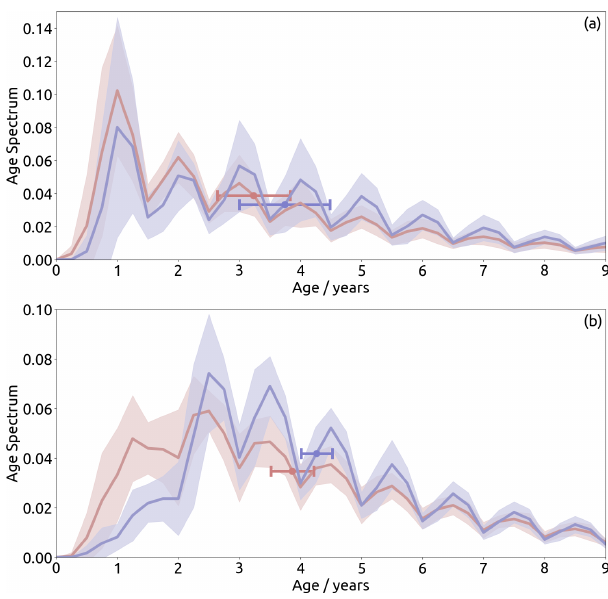
Figure 9. Age spectra from EMAC-FFSL (red) and EMAC-CLaMS (blue) within (a) the northern polar vortex (480K, 70–90 ◦ N, Jan- uary) and (b) the southern polar vortex (90–70 ◦ S 450K, July). Lines indicate multi-annual mean with shading showing annual variability. Dots indicate mean age of spectra, with surrounding bars showing annual variability. Variability for both quantities is com- puted as 2 standard